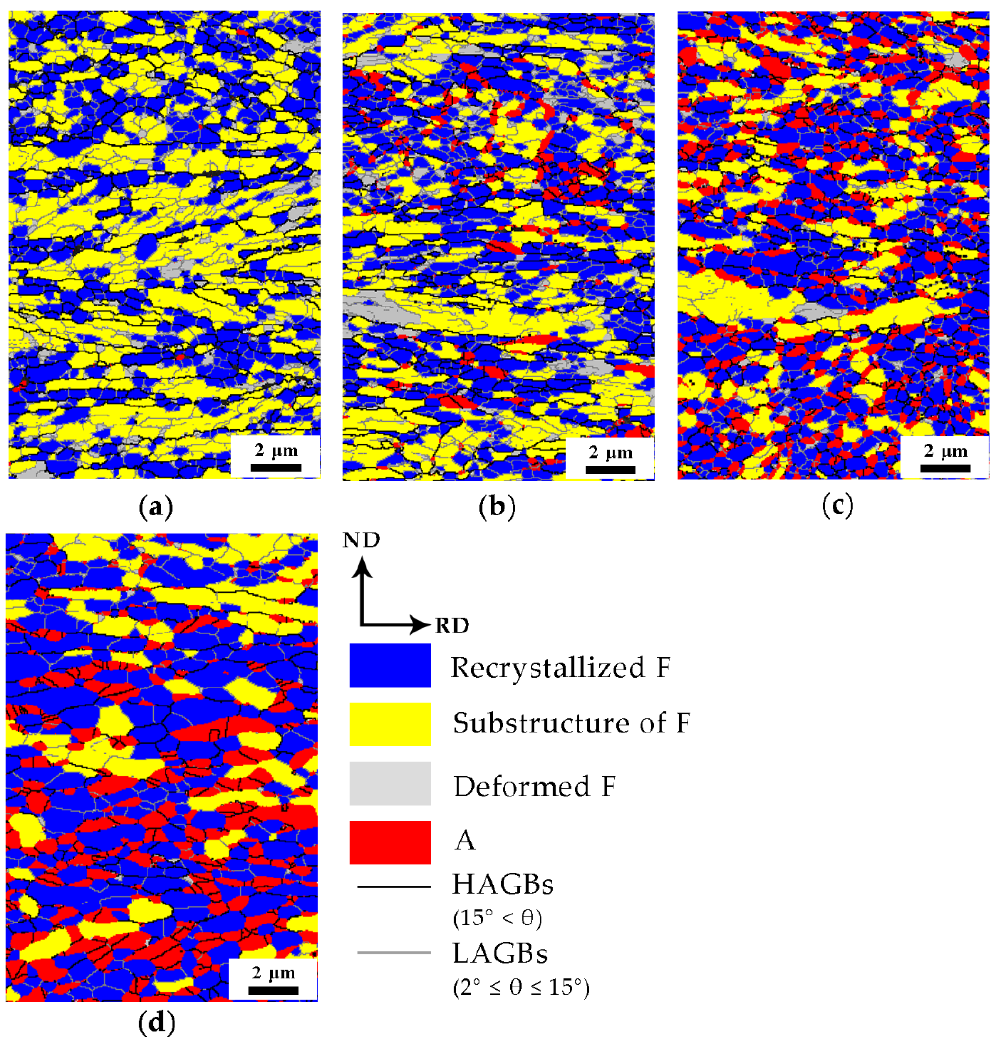
Figure 6. The evolution of the matrix microstructure for different intercritical annealing times at 675 °C of ( a ) 1 min, ( b ) 3 min, ( c ) 30 min and ( d ) 360 min.